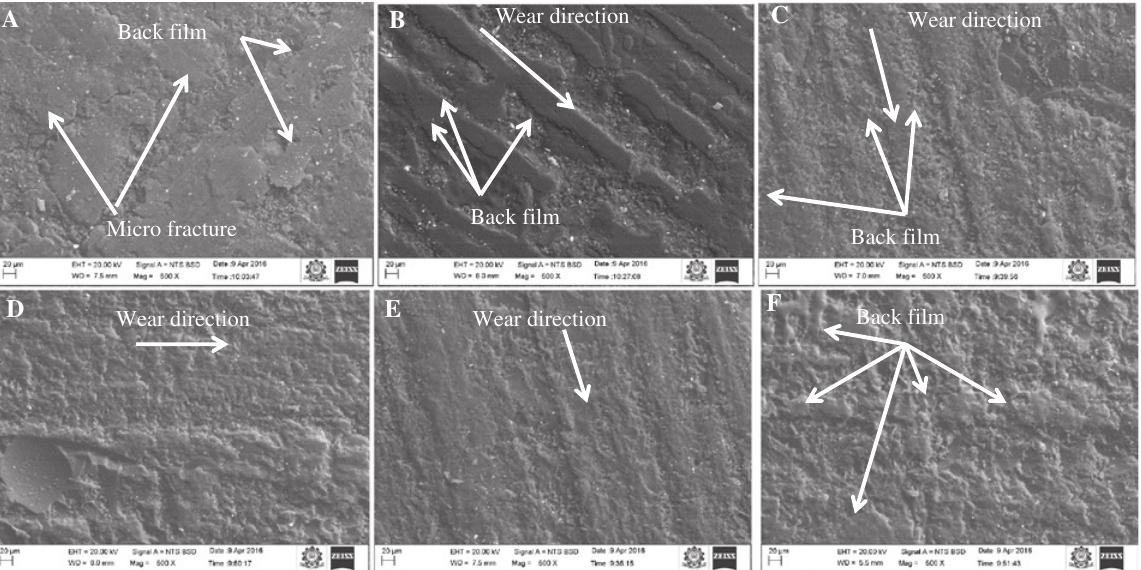
Figure 13: SEM image of the atrobo test worn-out surface: (A) 5% of CNS, (B) 15% of CNS, (C) 20% of CNS, (D) 25% of CNS, (E) 30% of CNS, and (F) 35% of